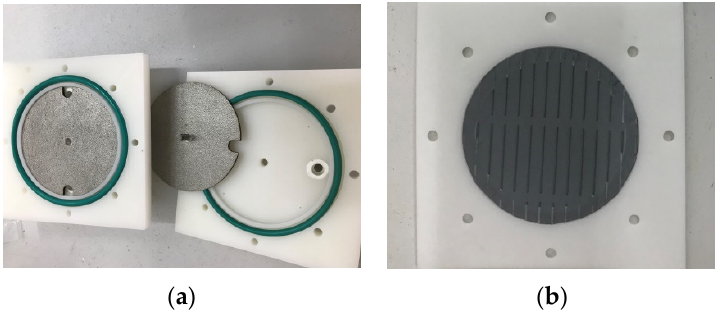
Figure 3. Photos of the cell structure ( a ) and the rib-like microporous exchange membrane ( b